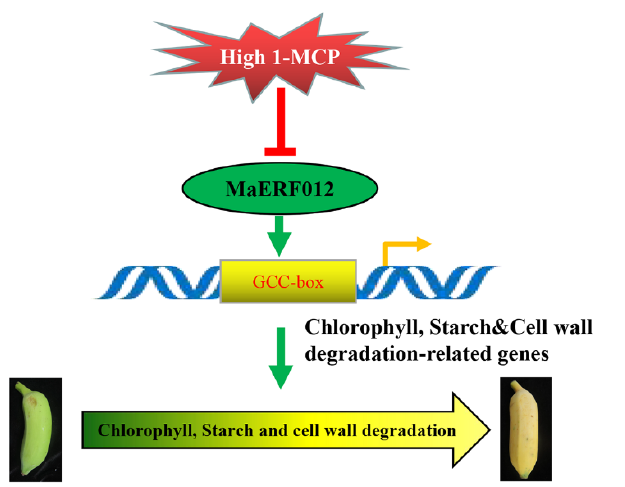
Figure 10. The proposed working model of MaERF012 regulating chlorophyll, starch, and cell wall degradation.